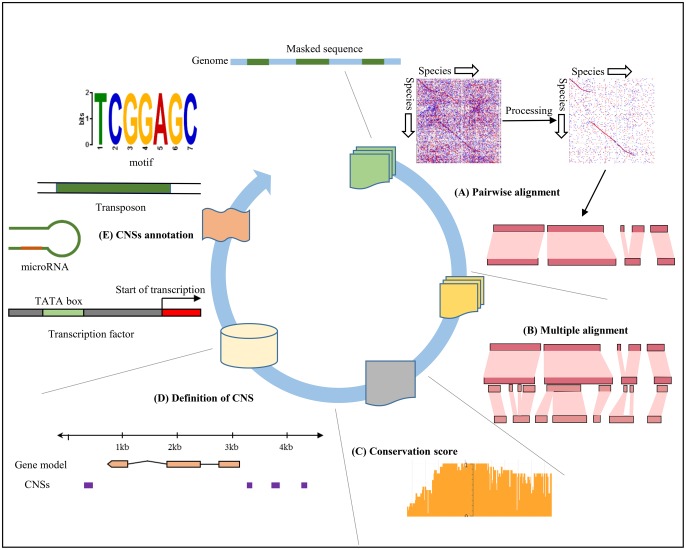
—Our CNSpipeline to identify conserved sequences through genome comparisons. The steps include: (A) pairwise genome comparisons followed by masking and chaining; (B) merge pairwise alignments into multiple alignments; (C) calculation of conservation score of each base; (D) prediction of CNSs based on our criteria; (E) annotations of CNSs against various genomic elements including known motifs, microRNA, and lncRNA when possible.